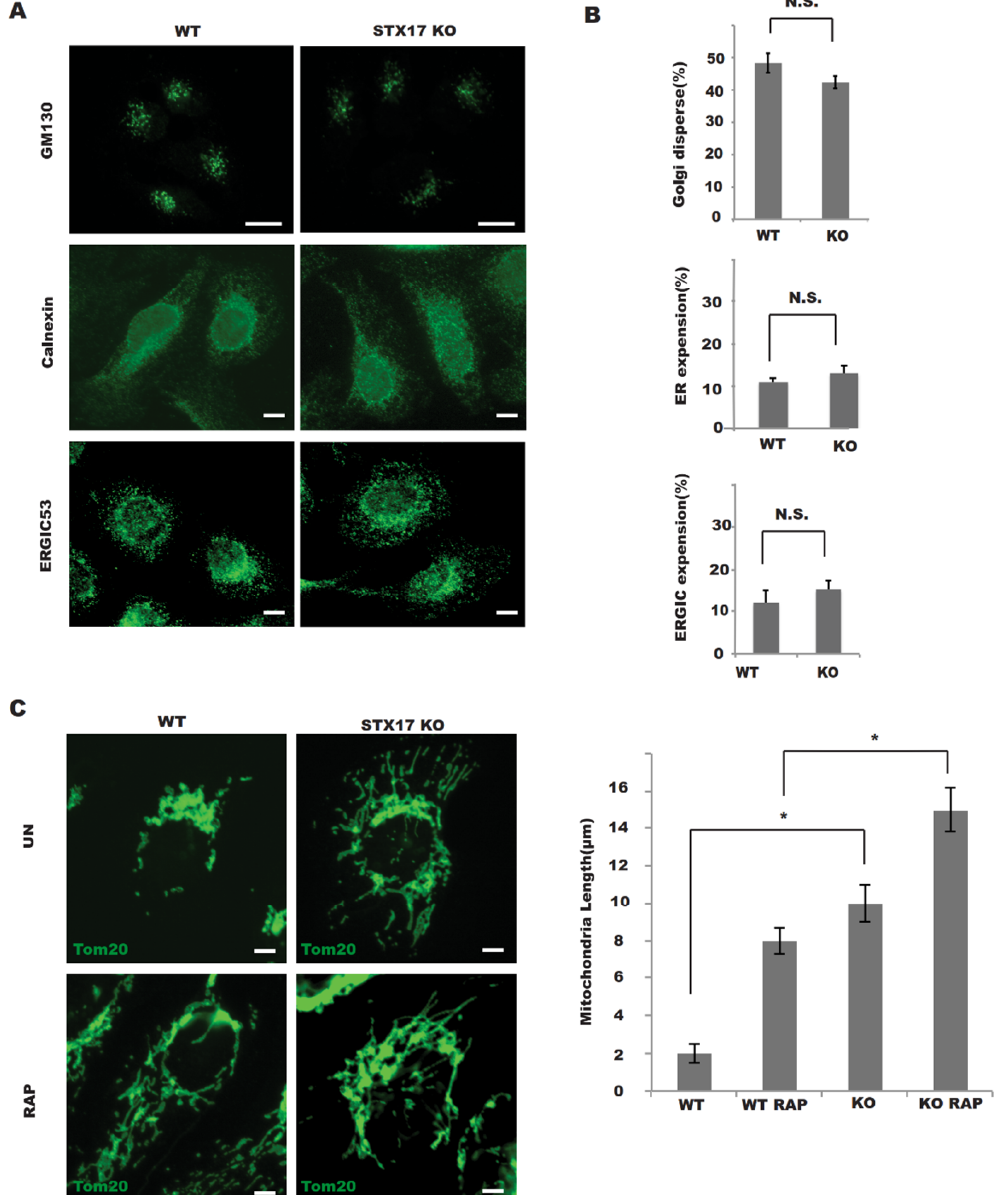
Figure 4. STX17 is required for mitochondrial fission but not for endoplasmic reticulum (ER) / ER–Golgi intermediate compartment (ERGIC) / Golgi architecture maintenance. ( A ) The morphology of the Golgi, ER and ERGIC marked by GM130, Calnexin and ERGIC53 staining was not altered in STX17 KO cells (Golgi dispersal was quantified by measuring the Golgi area per cell). Scale bar: 5 µ m. ( B ) Statistics analysis of data presented in A. No Significance (N.S.) * Significance ( C ) Mitochondria were elongated in STX17 KO cells. Wild Type(WT) or STX17 KO cells were fixed and stained with Tom20 endogenous antibody after Rapamycin treatment. Scale bar: 5 µ